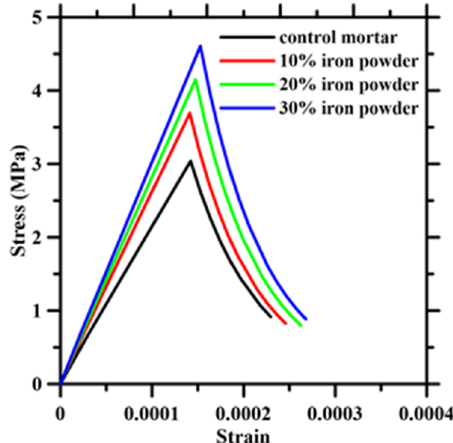
Figure 7. Progressive damage (interface / matrix) observed in iron powder (10%) modified mortar corresponding to applied tensile strains of ( a ) 52 µε , ( b ) 105 µε , ( c ) 153 µε and ( d ) 208 µε (the interface damage is highlighted in zoomed pictures).